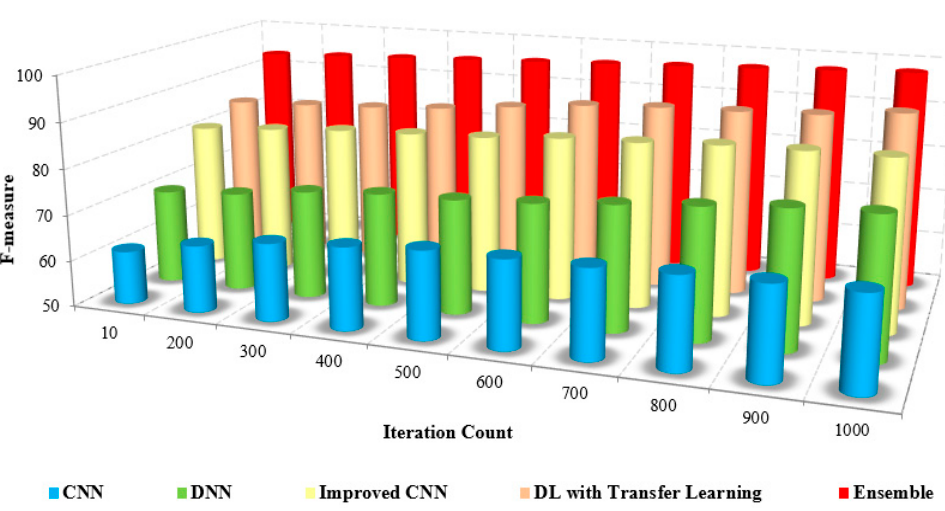
Figure 12. Iteration count vs.